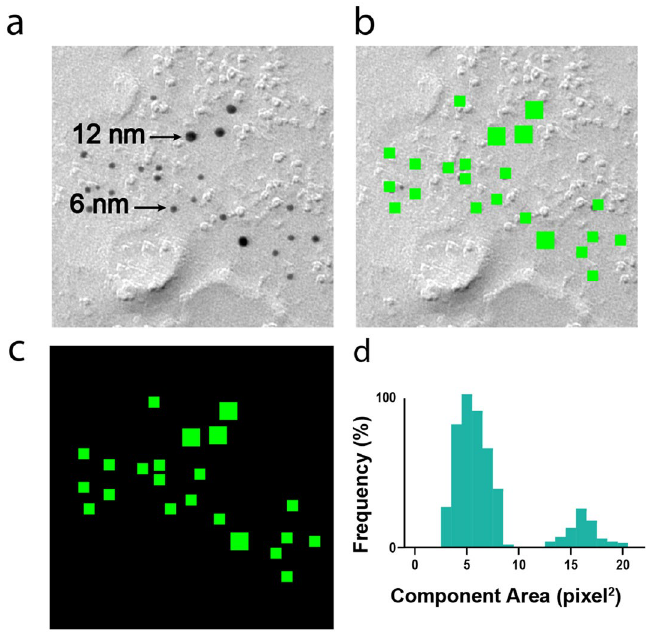
Figure 2. Annotation of individual gold beads. ( a ) Sample input FRIL image having two sizes of gold particles. ( b ) network-annotated output of ( a ). ( c ) Sample network output with background removed. ( d ) Clustering analysis used to group gold particles into two size groups. FRIL images were collected from cerebellar tissue expressing Td-tomato-tagged channelrhodopsin2, and labeled with antibody-conjugated gold nanoparticles.